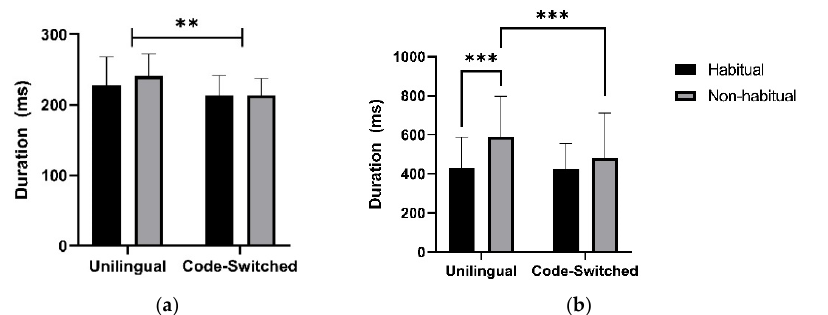
Figure 2. Comparison of ( a ) the first fixation duration and ( b ) the total visit duration. *** = p < 0.001, ** = p < 0.01.